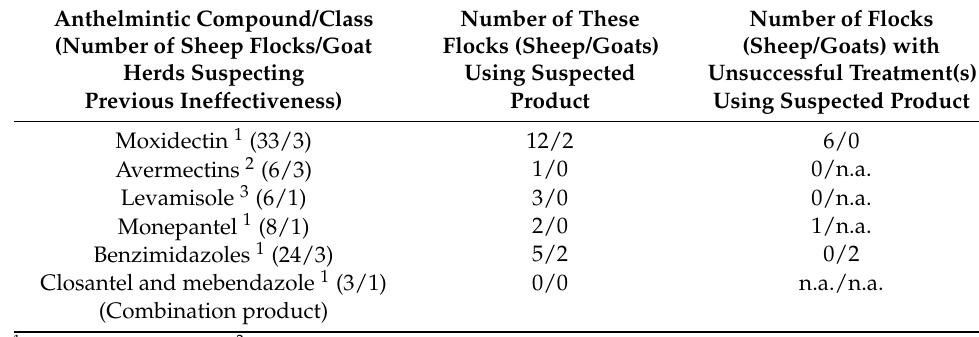
Table 2. Number of flocks (both small ruminant species) with suspected previous ineffective treat- ments as stated in the questionnaire, by anthelmintic category, and number of flocks using the suspected product for this study, including respective treatment success. Ineffectiveness was sus- pected for multiple compounds/classes by some participants. n = 72 flocks reporting 92 suspected previous treatment